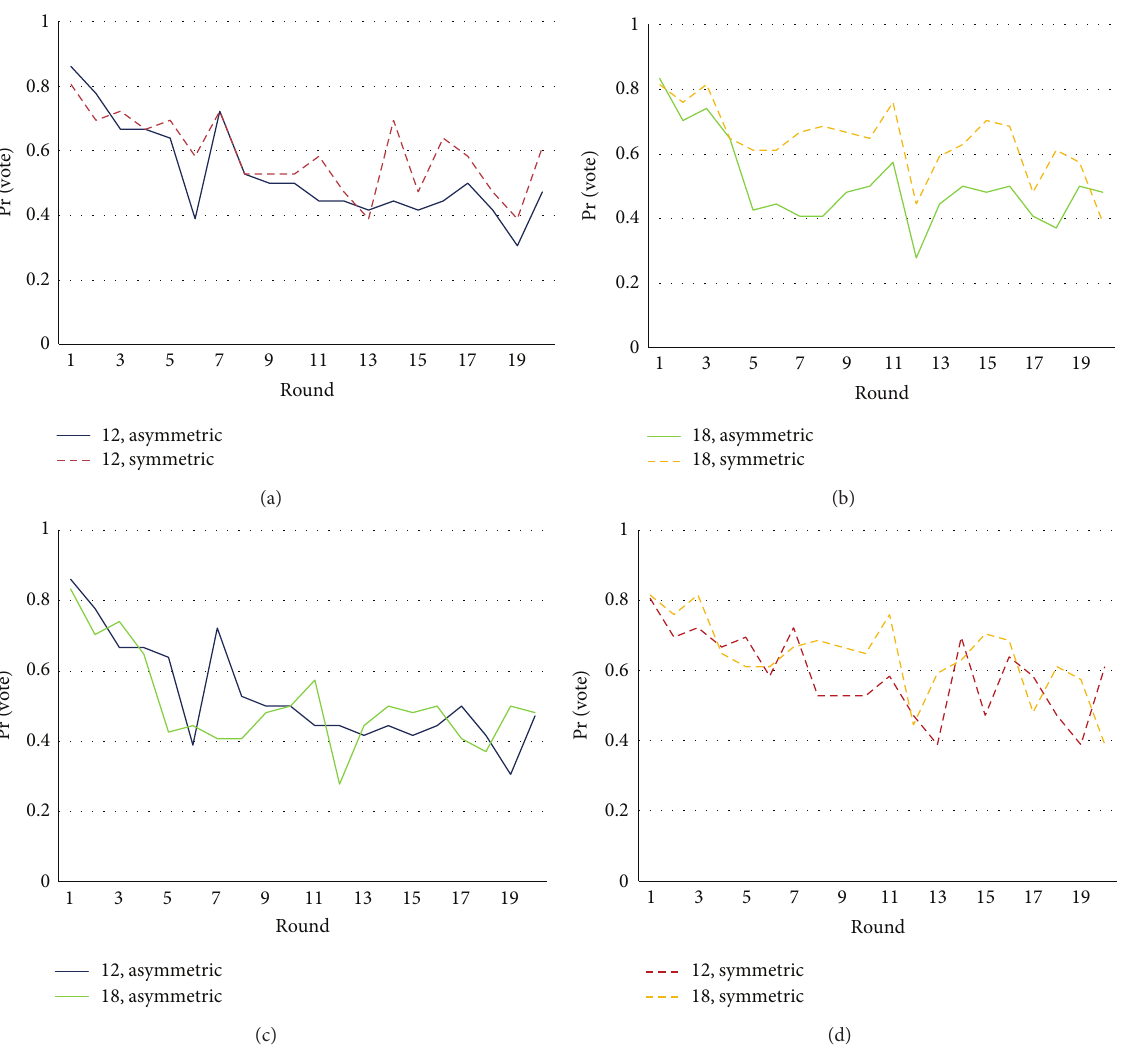
Figure 2: Voting turnout rates (top row symmetric versus asymmetric, bottom row 12 versus